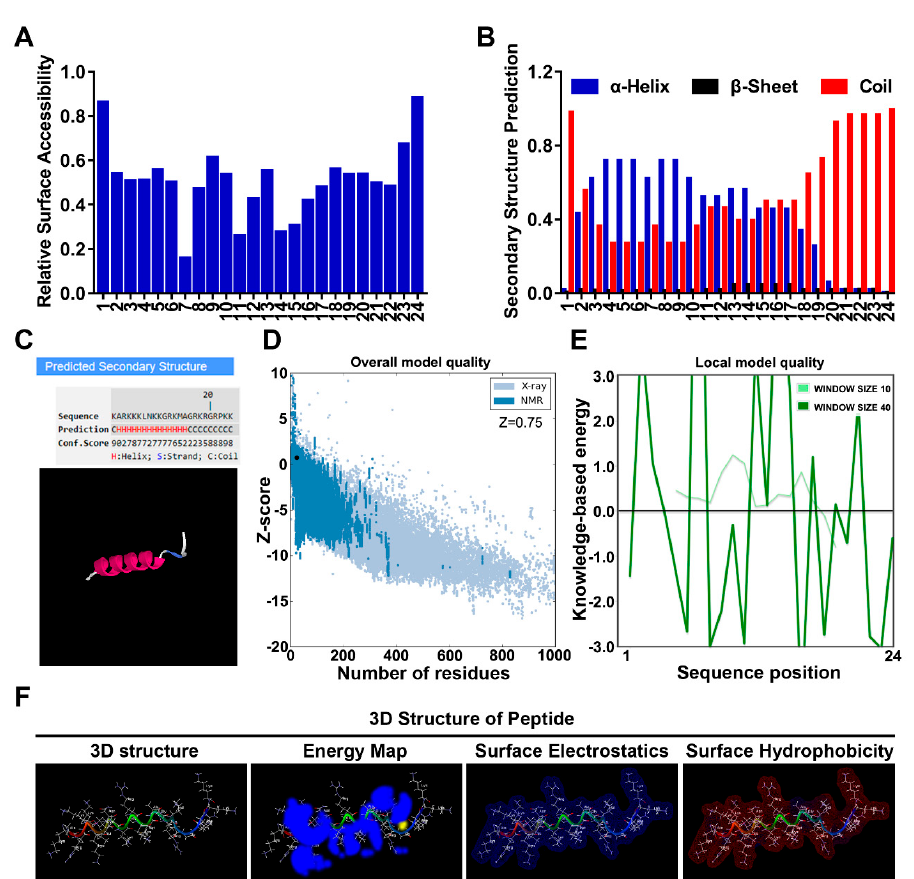
Figure 1. Dot1l peptide structure prediction. ( A ) Relative surface accessibility prediction of Dot1l peptide by the NetSurfP web server. ( B ) Dot1l peptide secondary structure prediction on the NetSurfP web server. ( C ) Structural model of Dot1l peptide predicted on the I-TASSER server. ( D ) ProSA-web z score plot for the Dot1l peptide 3D structure generated from the I-TASSER server. ( E ) ProSA local model quality/residue-wise energy plot of the Dot1l peptide 3D structure generated from the I-TASSER server. ( F ) Representation tridimensional structure, energy map, surface electrostatics, and surface hydrophobicity of Dot1l peptide.